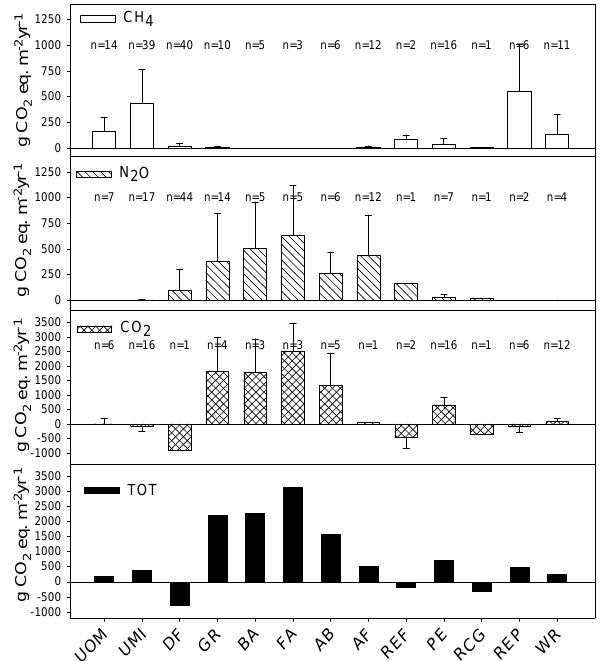
Fig. 1 Fig. 1. The mean values of reported annual net fluxes of CH 4 , N 2 O and CO 2 exchange and the net effect of these gases as gCO 2 equivalentsm − 2 (100-year time horizon) from different peat- land categories in the Nordic countries (UOM=undrained om- brotrophic peatlands and UMI=undrained minerotrophic peat- lands (from Saarnio et al., 2007), DF=ombrotrophic and minerotrophic sites drained for forestry, GR=drained for agri- culture – grass, BA=agriculture – barley, FA=agriculture – fallow, AF=agriculture – afforested, AB=agriculture – aban- doned, REF=forestry – restored, PE=drained for peat extraction, PEF=peat extraction – afforested, RCG=abandoned peat extrac- tion – cultivation of reed canary grass, REP=drained for peat ex- traction – restored, WR=water reservoirs). A negative value indi- cates uptake by the ecosystem and a positive value net emission, n =number of sites, error bars indicate standard deviation between